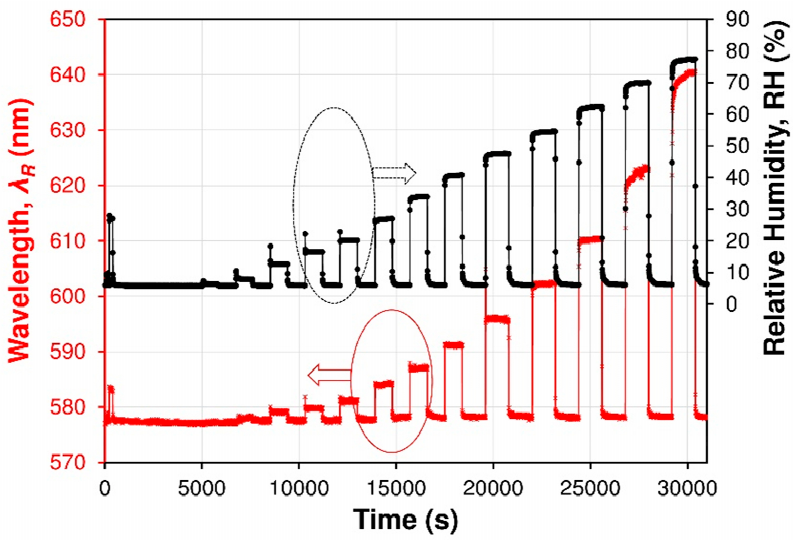
Figure 10. Spectral response (resonant wavelength λ R shift) of the Nafion ® -based fiber optic device used as FPI sensor (red line) and of a commercial SHT75 sensor (black dotted line). The FPI sensor device was set near the commercial sensor in the measurement flow cell, where the humidity was changed with time.